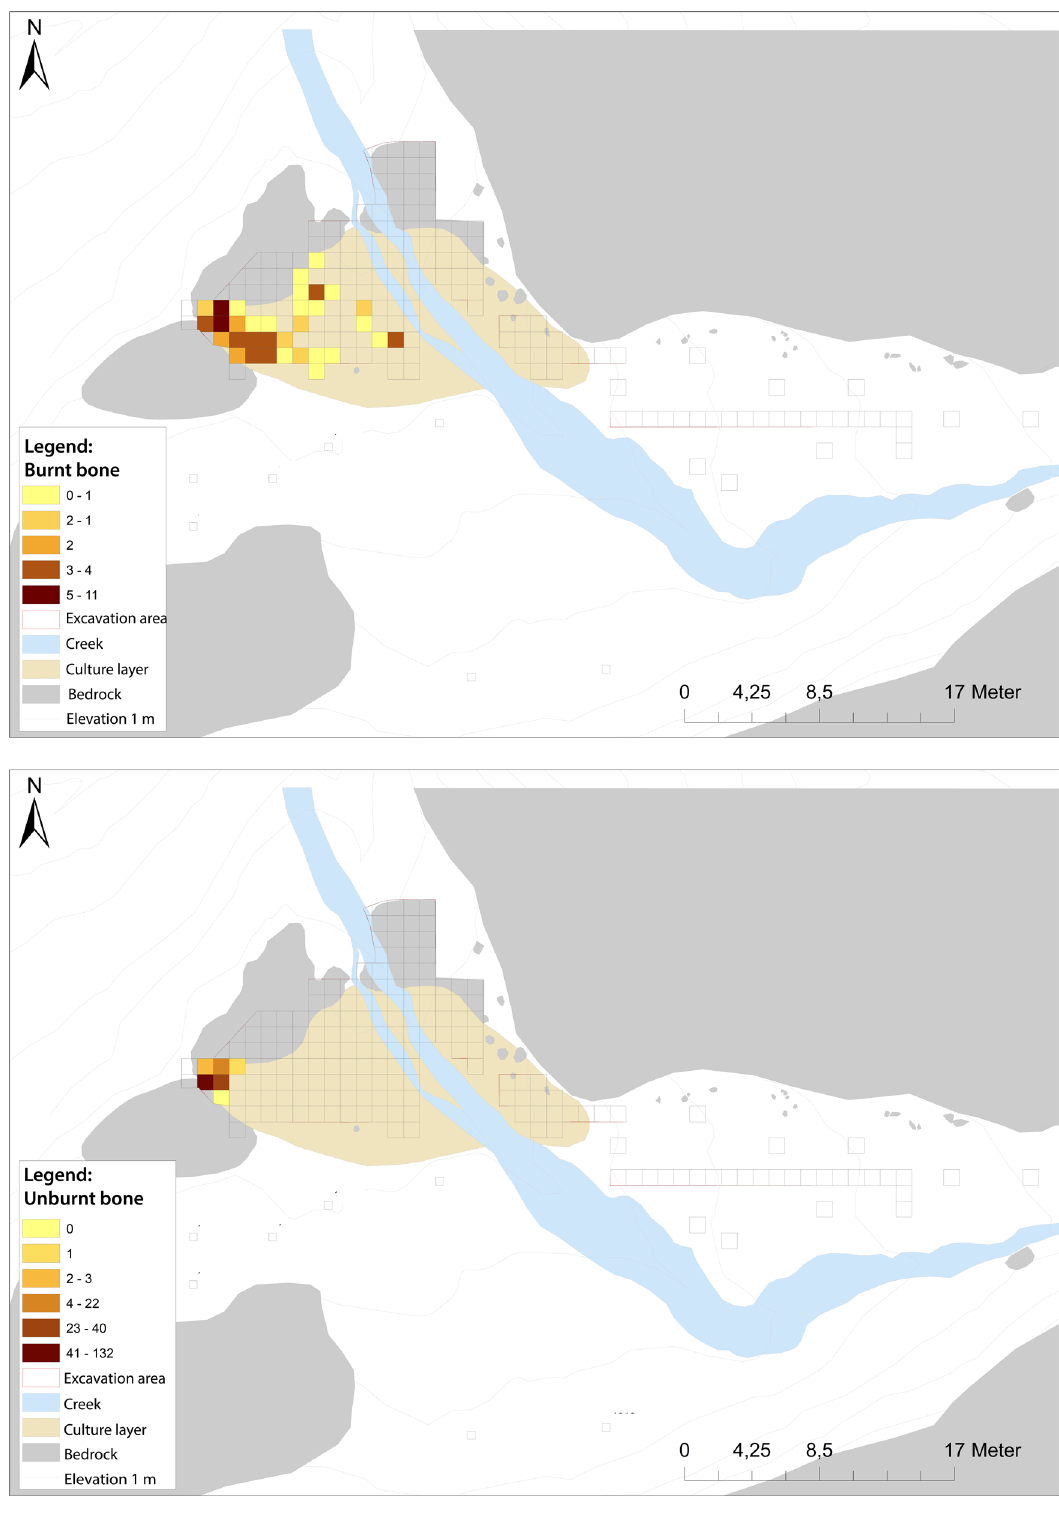
Figure 2: Distribution of cultural layer and animal bones at the Alveberget site. The unburnt bones ( lower ) were found in small rock hollows along the western edge of the site, close to the past shoreline, suggesting that faunal remains had been discarded in the sea. The burnt bones ( upper ) were more widely distributed ( Map: J. S. F. Stokke/I. M. Berg - Hansen © 2020 Museum of Cultural History, University of Oslo )